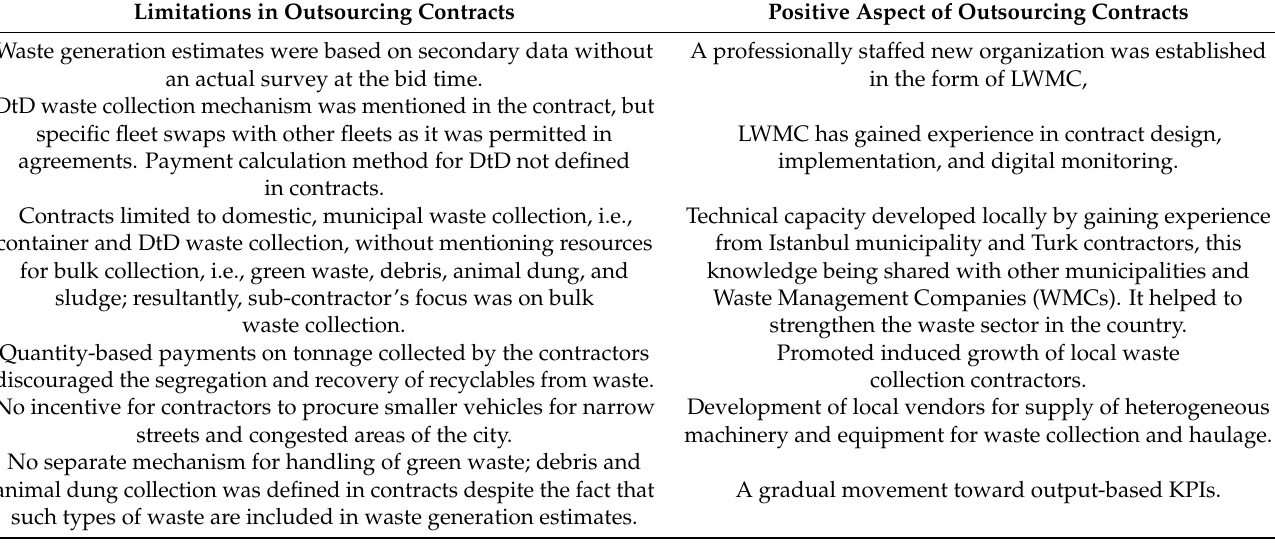
Table 2. Lesson learned from previous SWM outsourcing